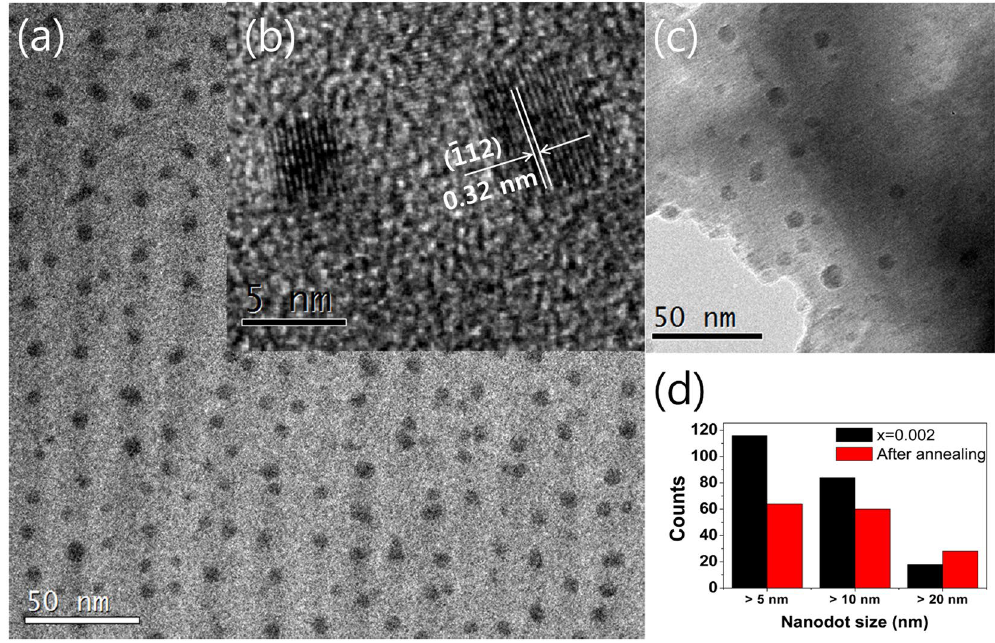
Figure 5. ( a ) Transmission electron microscopy (TEM) images of the x = 0.002 sample in AgSb 1 − x Ce x Te 2 , ( b ) magnified images of Ag